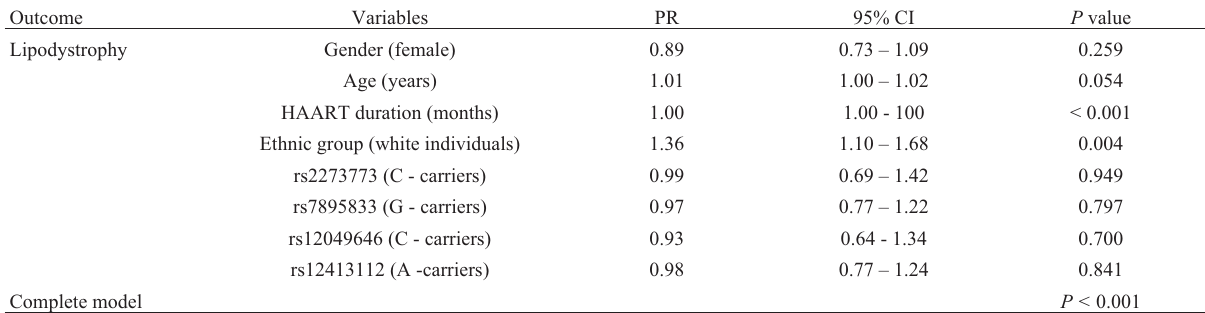
PR, prevalence ratio, 95% CI; 95% confidence